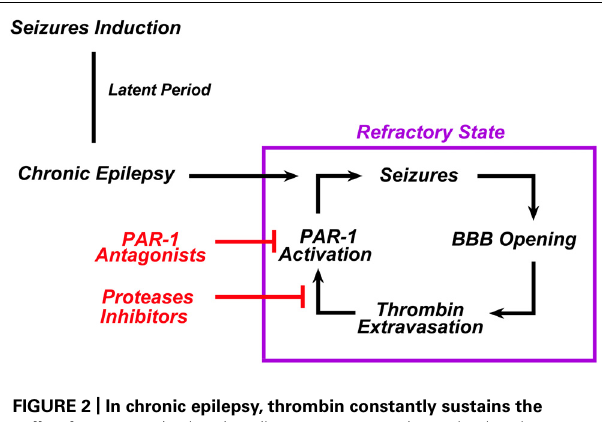
FIGURE 2 | In chronic epilepsy, thrombin constantly sustains the epileptic process. In chronic epilepsy, recurrent seizures lead to the breakdown of BBB. Extravasation of thrombin from the blood into the brain tissue activates PAR-1 in the brain. PAR-1 activation sustains or even enhances the epileptogenic processes responsible for the refractoriness of such syndrome.The use of either PAR-1 antagonists and/or serine proteases inhibitors could break this vicious cycle and prevent the occurrence of